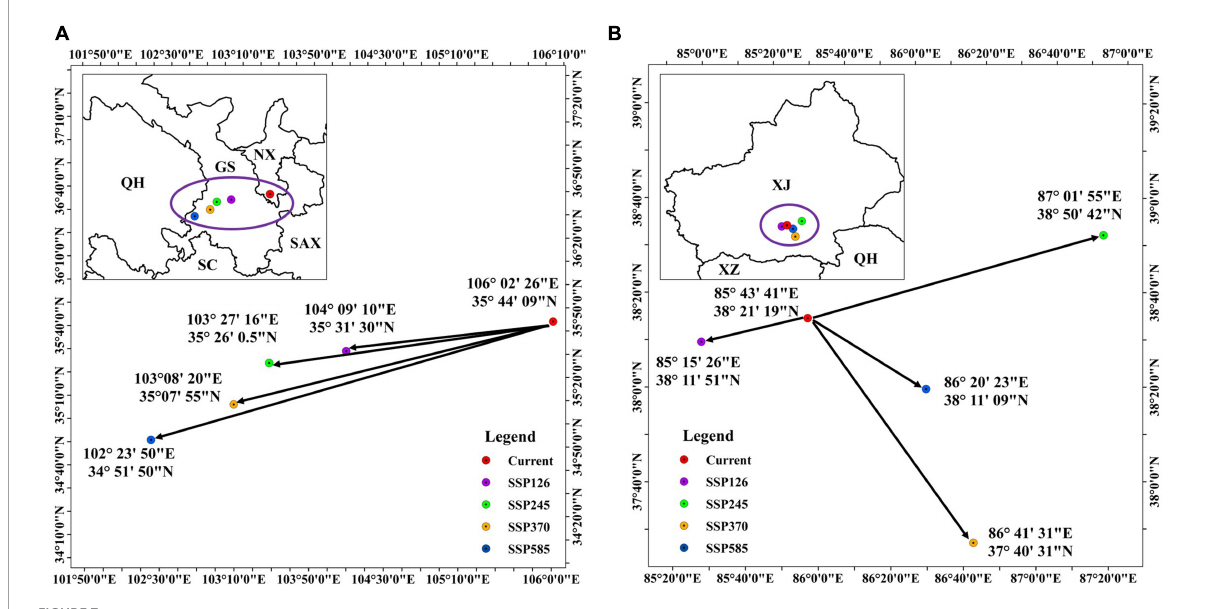
FIGURE7 The centroid migration of suitable habitats of (A) H. r. sinensis and (B) H. r. turkestanica